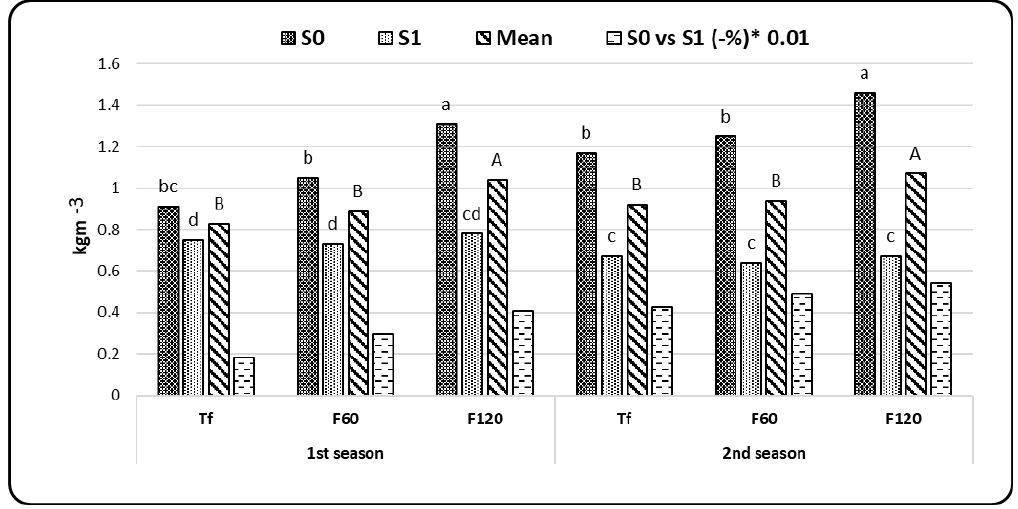
− 3 ) under di ff erent planting methods (M) and salinity conditions Figure 3. P IW (kg m −3 ) under different planting methods (M) and salinity conditions (S). Figure 3. P IW (kg m